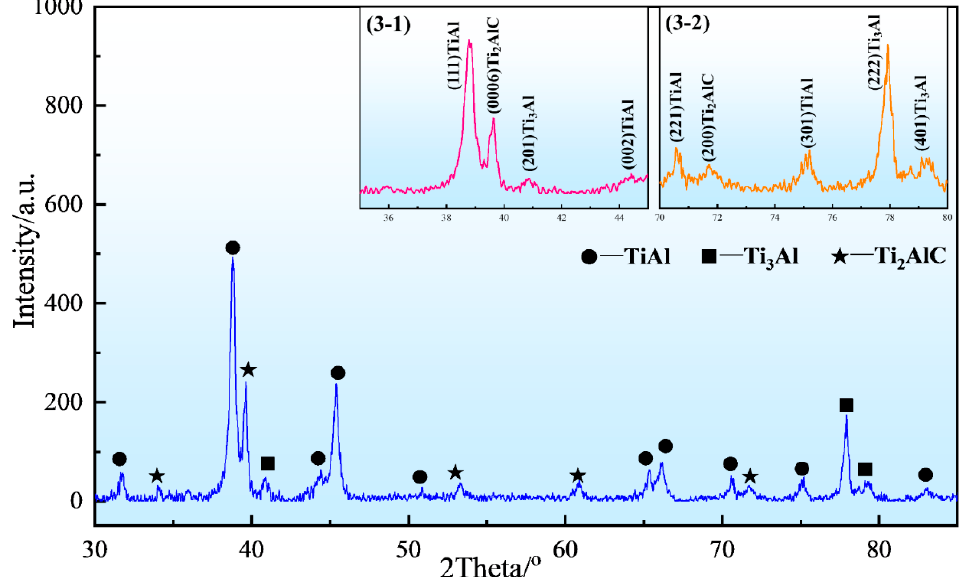
Figure 3. The XRD pattern of the as-prepared Ti 2 AlC/TiAl composite: ( 3-1 ) the local enlarged image of 35–45 ◦ ; ( 3-2 ) the local enlarged image of 70–80 ◦ .